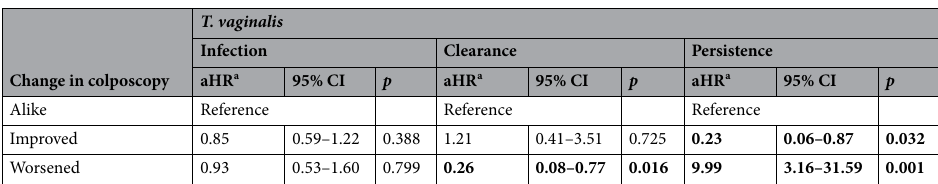
Table 3. Adjusted hazard ratio for modelling the relationship between change in colposcopy results and TV-outcome. HR hazard ratio, 95% CI 95% confidence interval, STI sexually transmitted infection. Values in bold indicate p ≤ 0.05. a Hazard ratio adjusted for ethnicity, age, marital status, years of active sex life, amount of sexual partners, pregnancies, contraceptive method used, abortions and active